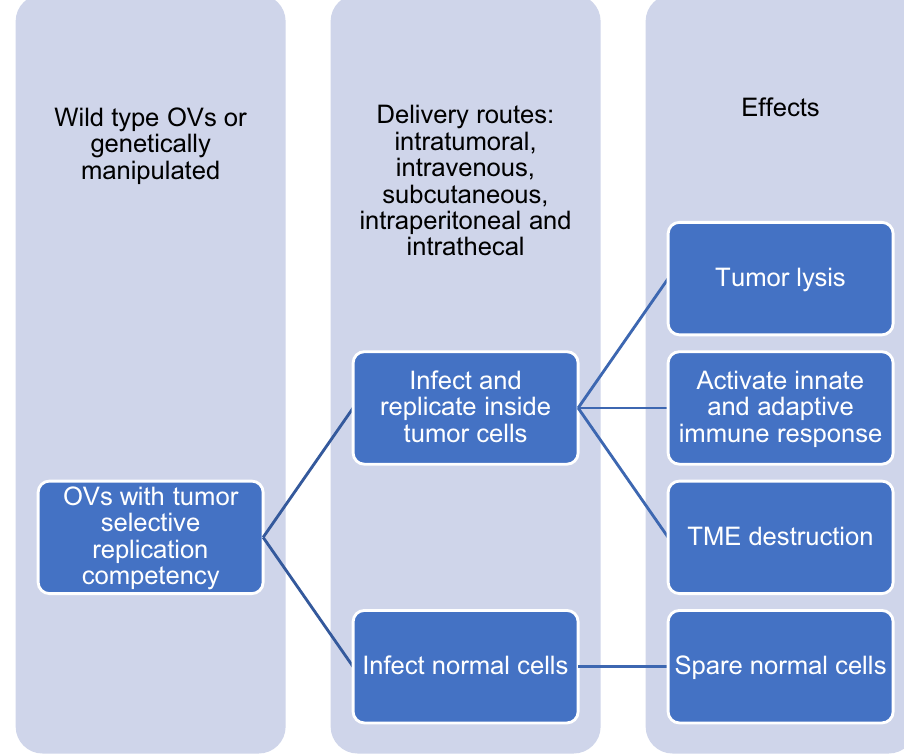
Fig. 3 Oncolytic virus therapy as a novel therapy sparing normal